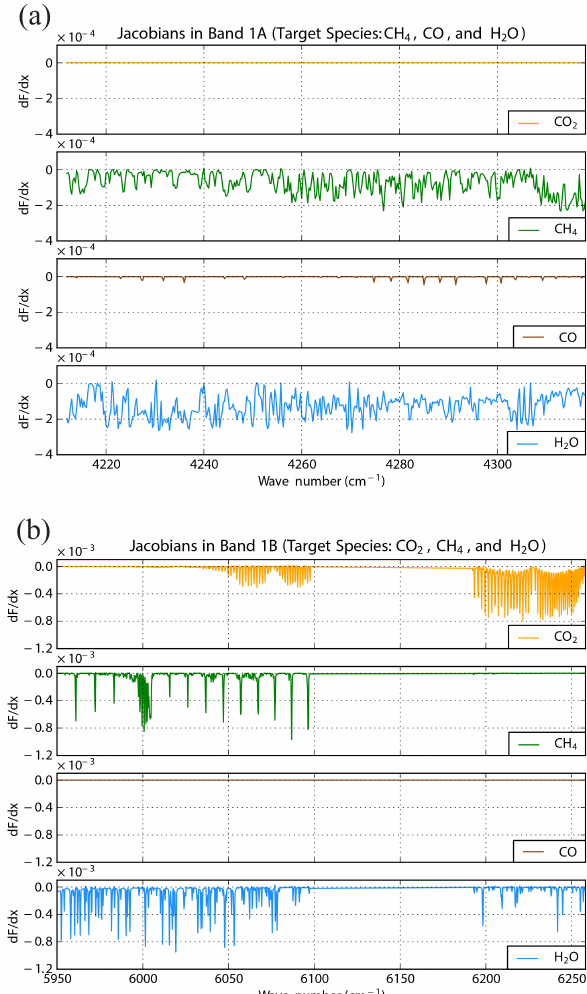
Figure 5. The Jacobians of four target species in (a) Band 1A and (b) Band 1B. Since x is a unitless scaling factor, the Jacobian (d F/ d x ) has the same unit as the modeled radiances in Fig.